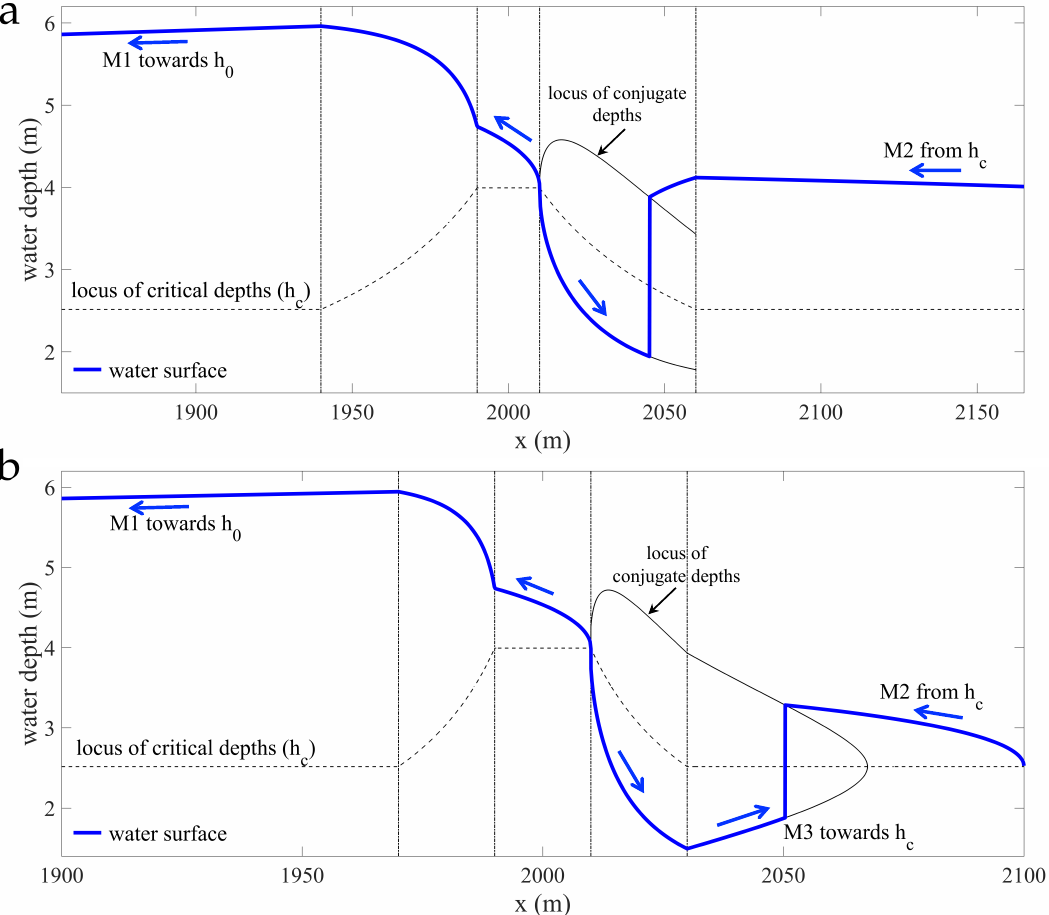
Figure 4. Construction of water surface profiles for transcritical flow past a channel contraction using the 1D energy-momentum theory. Blue arrows indicate hydraulic control under mild slope conditions, and direction of integration of Equations (1) and (2). ( a ) A sample case where the hydraulic jump is contained within the expansion zone. The distance from the center of the constriction to downstream boundary condition is L d = 250 m, the length of the segment with maximum contraction is L b = 10 m, the length of the contracting/expanding zones is L e = 50 m, and the channel widths b 1 and b 2 are 40 m and 15 m, respectively, according to the schematic in Figure 3a. The discharge is Q = 500 m 3 /s, and Manning’s coefficient is n = 0.0389. ( b ) A sample case where the hydraulic jump is expelled outside of the expansion zone. In this case L d = 100 m and L e = 20